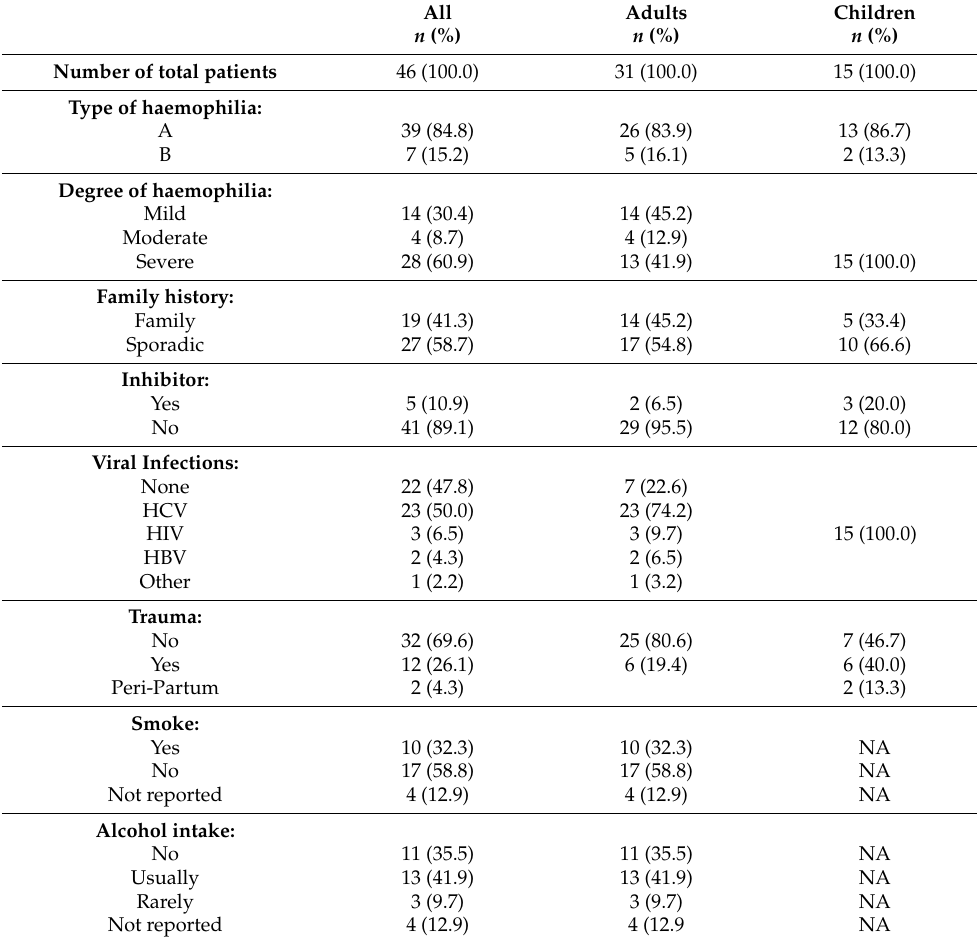
Table 1. Baseline characteristics of patients at intracranial haemorrhage diagnosis. Symptoms, sites and outcomes of intracranial haemorrhage (ICH). * Patients can have one or more symptoms or ICH sites. NA: not applicable; data referred only to adult patients ( n =